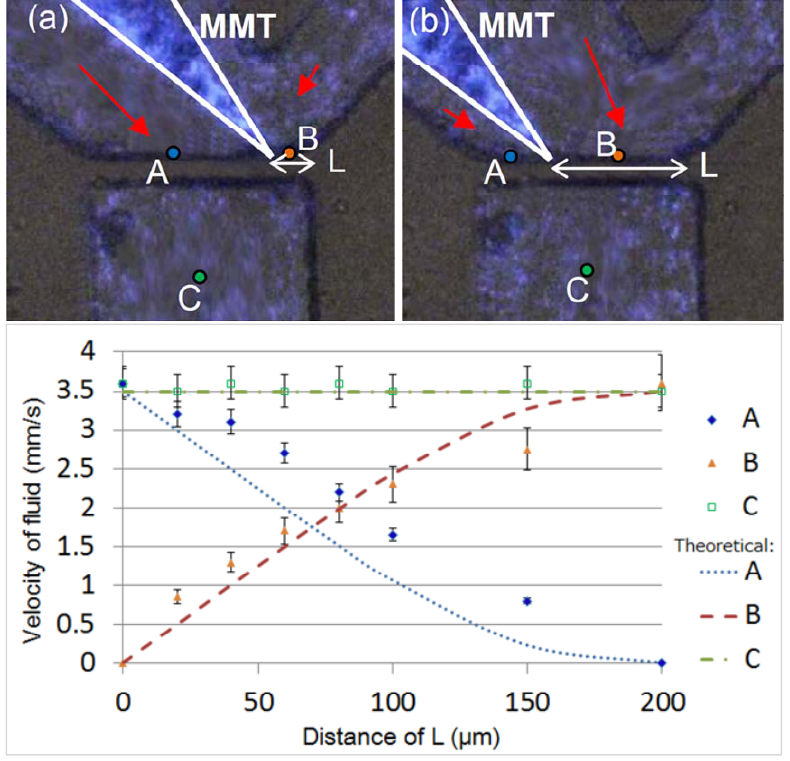
Figure 3. Theoretical and experimental values of the fluid velocity changes at three points in the channel. The velocity of the outflow is set to 3.5 mm/s. ( a ) In case that the MMT is near the right-side corner, ( b ) In case that the MMT is the left-side